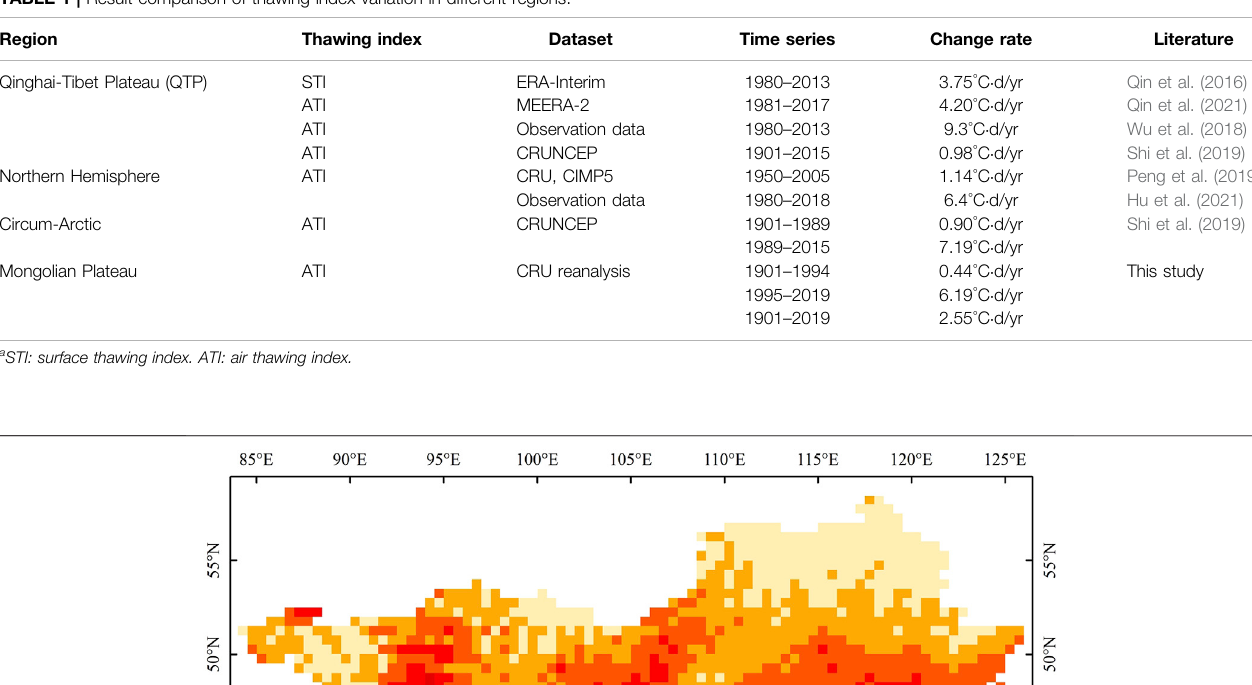
TABLE 1 | Result comparison of thawing index variation in different regions.